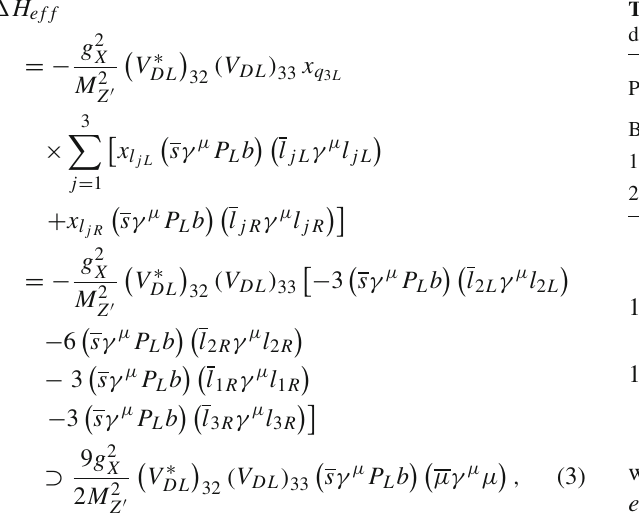
μμ Wilson coefficient from the LHCb 9